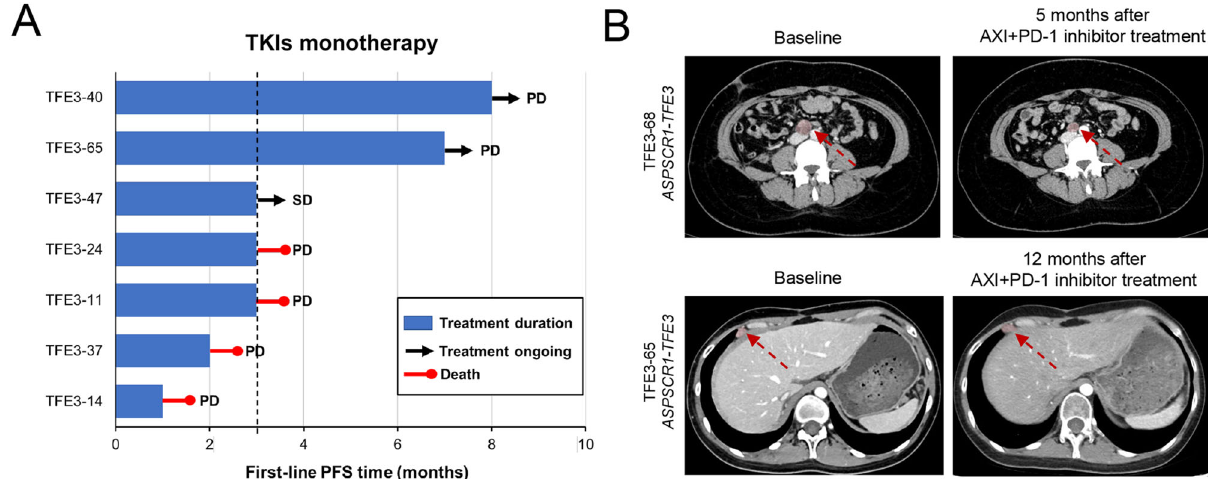
Fig. 6 Responses to systemic treatment and potential therapeutic targets for patients with TFE3-tRCC. A Swimmer plot depicts the PFS of individual patients receiving fi rst-line TKIs treatments. Vertical line indicates PFS at 3 months. B Baseline imaging in two patients (TFE3-68 and TFE3-65) before initiation of systematic treatment and after they received the combination of pembrolizumab plus axitinib treatment. TFE3 -tRCC TFE3 -translocation renal cell carcinoma, TKIs tyrosine kinase inhibitor, PFS progression-free survival. Arrow indicates tumor